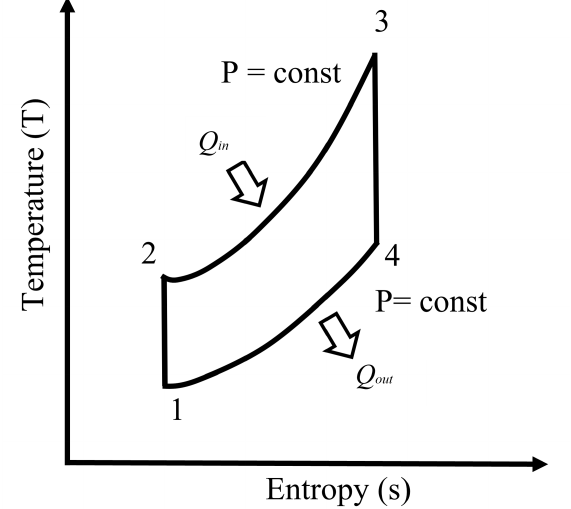
Figure 6. Brayton cycle temperature-entropy